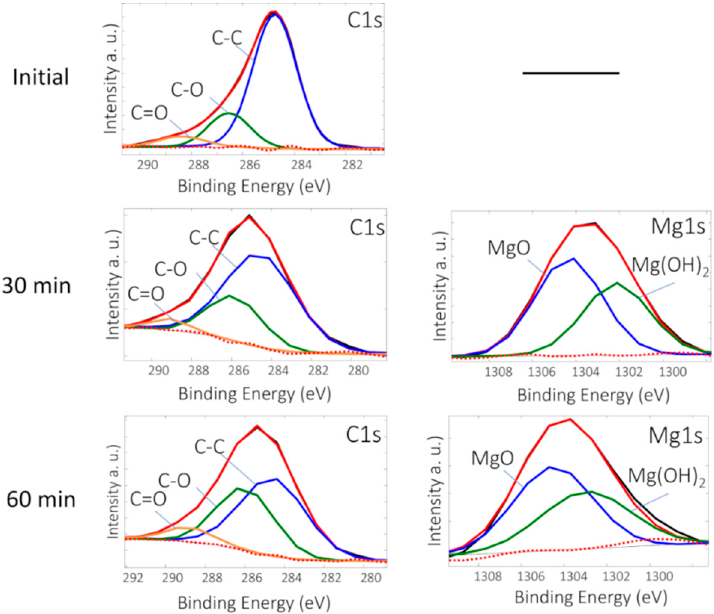
Table 1. Concentrations of elemental composition (up to 10 nm) before and after the plasma treatment.